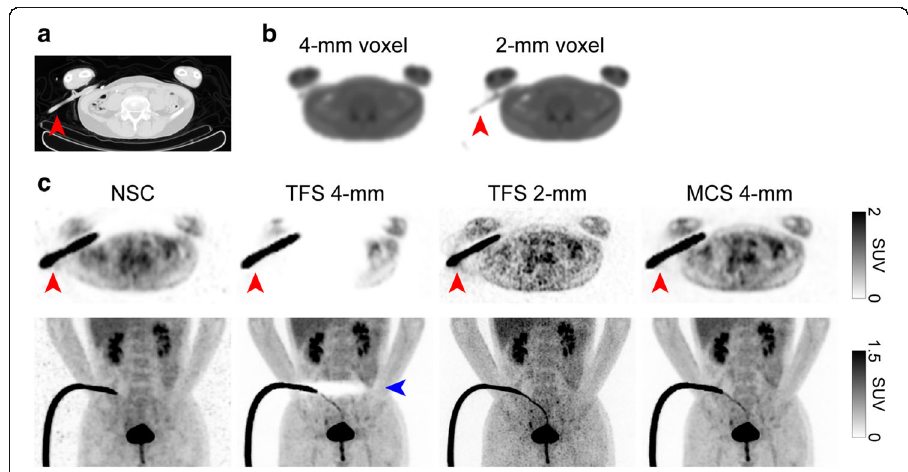
maps ( b ), PET images with non-scatter-correction (NSC), TFS 4-mm, TFS 2-mm, and MCS 4-mm ( c ). Red arrows : urinary catheter with urine. Blue arrow : halo artifact